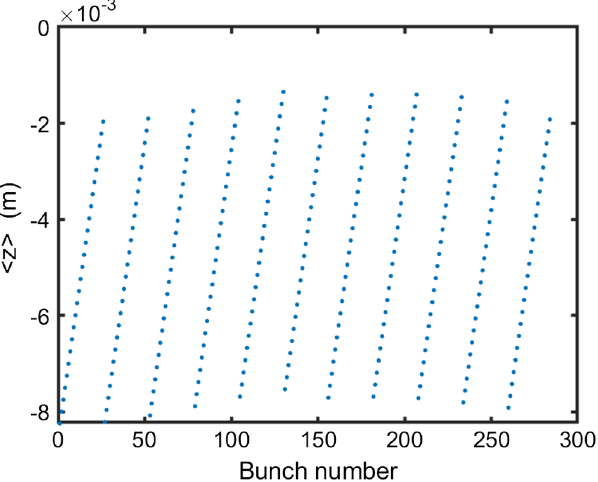
backward.FIG. 9. Centroid vs bunch number, with distributed